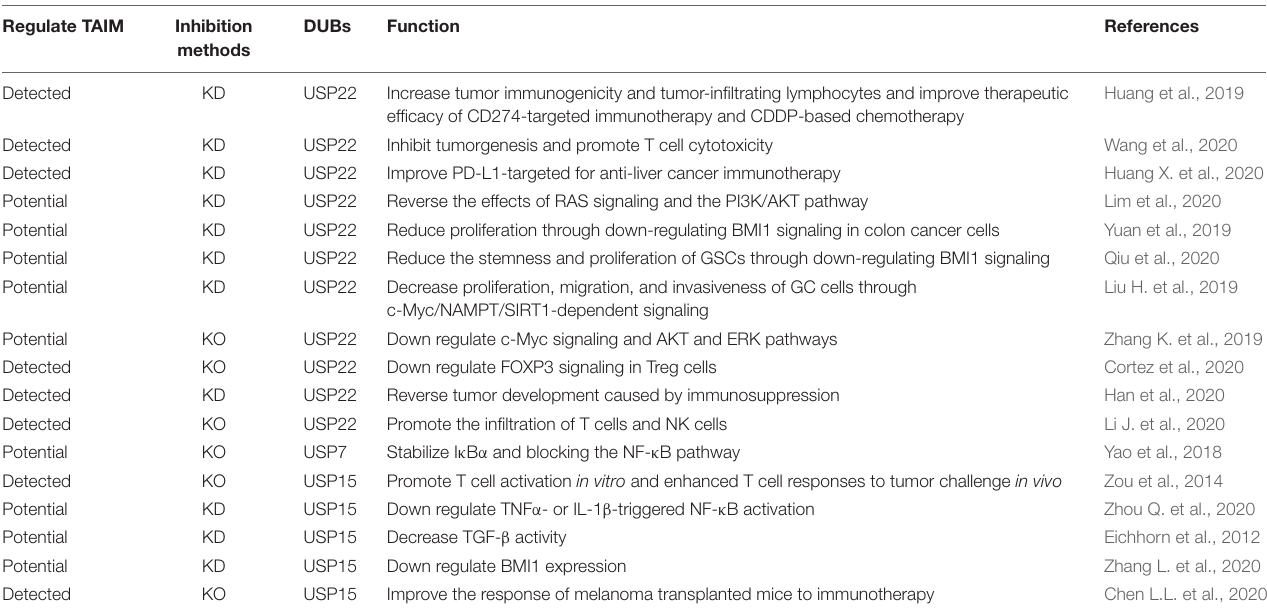
TABLE 3 | Related research on other inhibition methods of DUBs that regulate